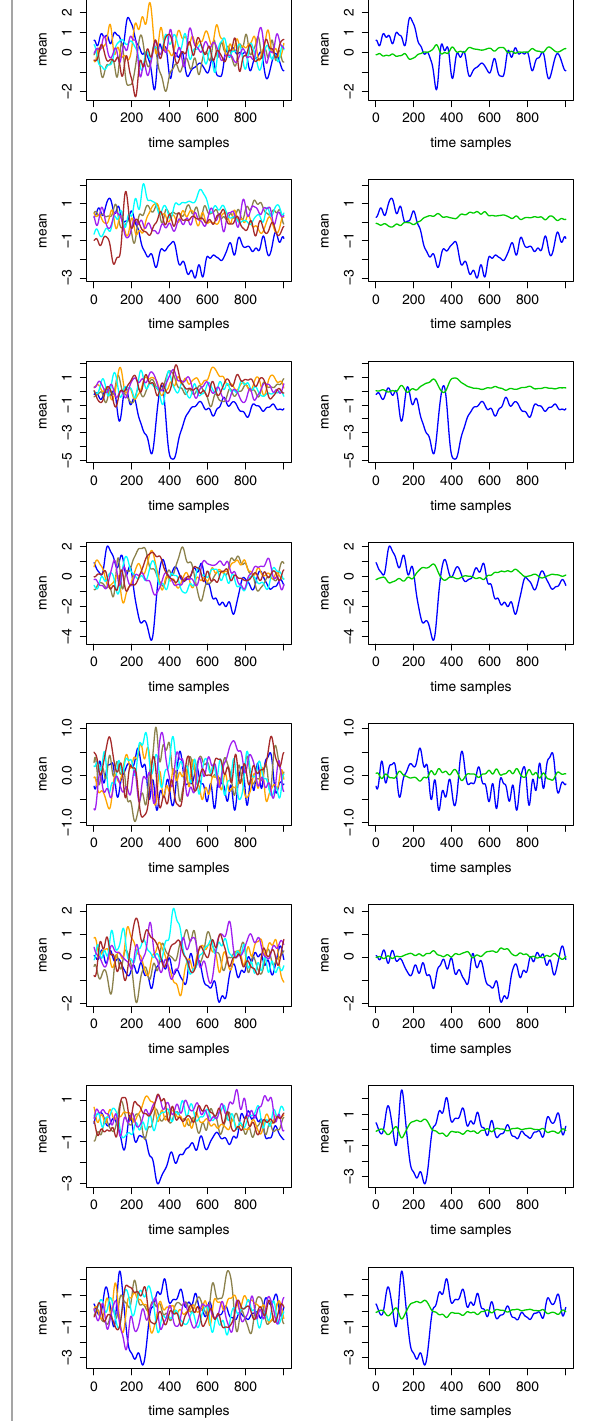
Fig. 13 Mean traces for different tag (left) and PIN (right) values. User 1 (top) to 8 (bottom), Electrode